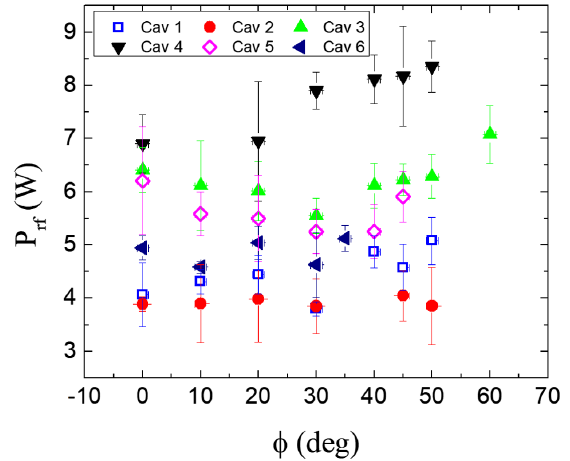
FIG. 11. The rf heat load at 2.07 K and E measured as a function of the detuning angle for cavities 1 – 6 in C20 CM FEL04.